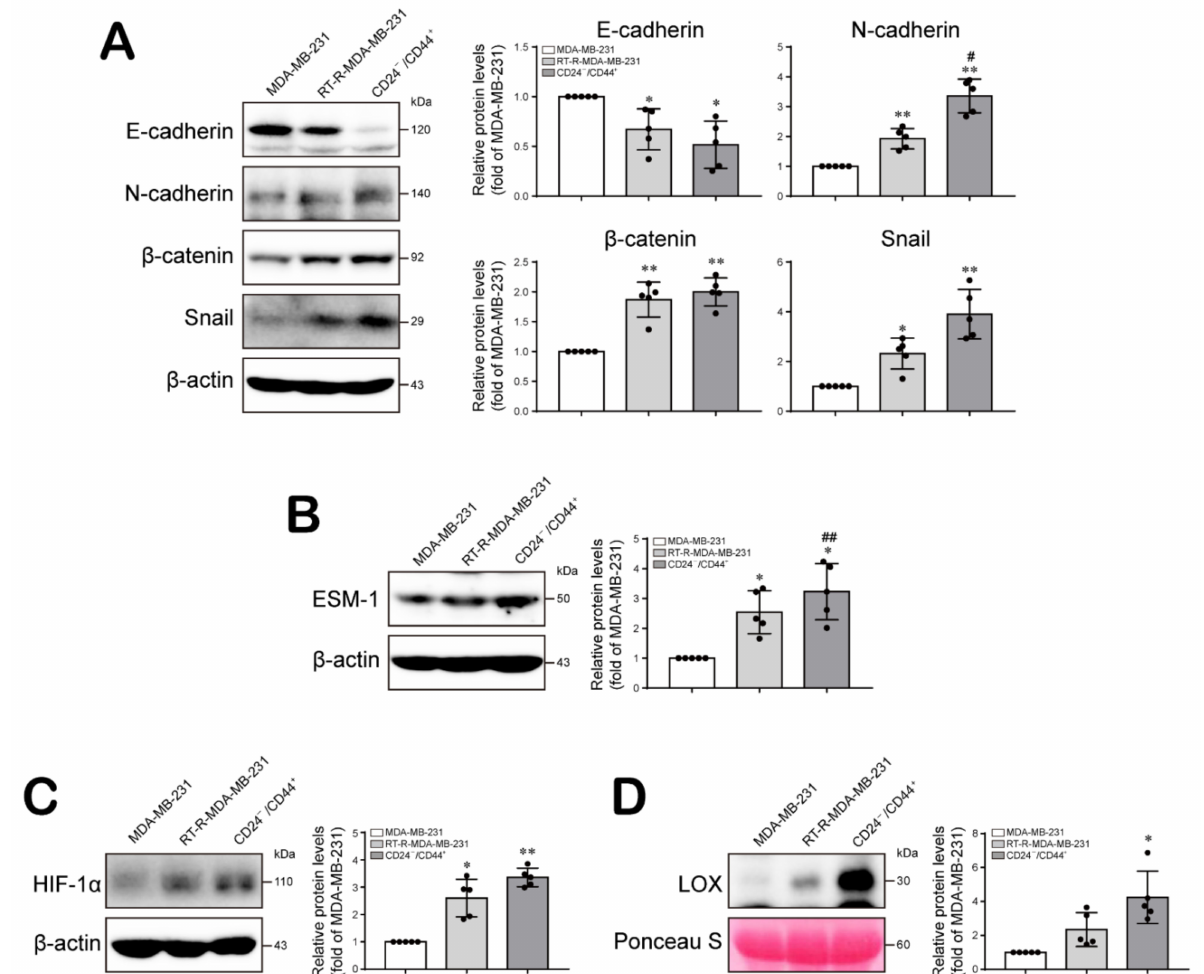
Figure 2. CD24 − /low /CD44 + BCSCs increase the expression levels of tumor progression-related proteins and decrease the expression of NK cell function-related ligands on cancer cells. ( A – C ) The protein expression levels of EMT-related molecules (E-cadherin, N-cadherin, β -catenin, and Snail) ( A ), a tumor progression-related molecule (ESM-1) ( B ) and metastasis-related molecules (HIF-1 α and LOX) ( C , D ) were determined in whole-cell lysates or conditioned medium of MDA-MB-231, RT-R-MDA-MB-231, and CD24 − /low /CD44 + cells by Western blotting as described in the Materials and Methods section. β -Actin detection and Ponceau S staining were used as loading controls. The values are presented as the mean ± SD of five independent experiments. * p < 0.05, ** p < 0.01 compared to MDA-MB-231 cells; # p < 0.05, ## p < 0.01 compared to RT-R-MDA-MB-231